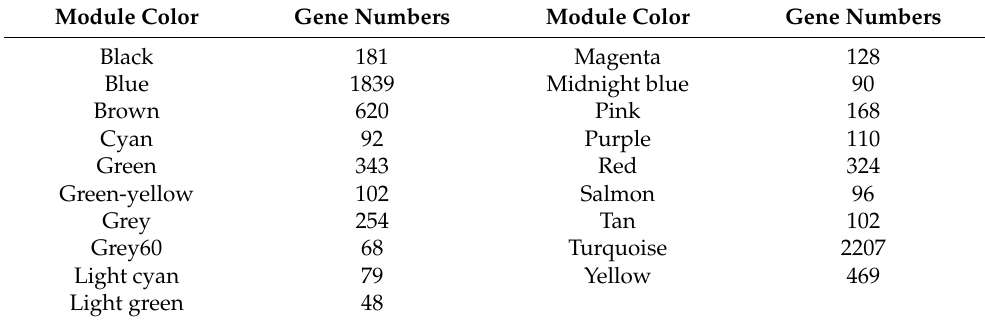
Figure 2. Construction of the weighted gene coexpression network. ( A ) Hierarchical clustering information of samples, ( B ) soft threshold filtering, the red line is β = 0.8, and the red number represents the β value, ( C ) gene coexpression network gene clustering number, and ( D ) network heatmap of gene–gene, different colors represent different gene modules. Table 2. Statistical table of modules’ gene